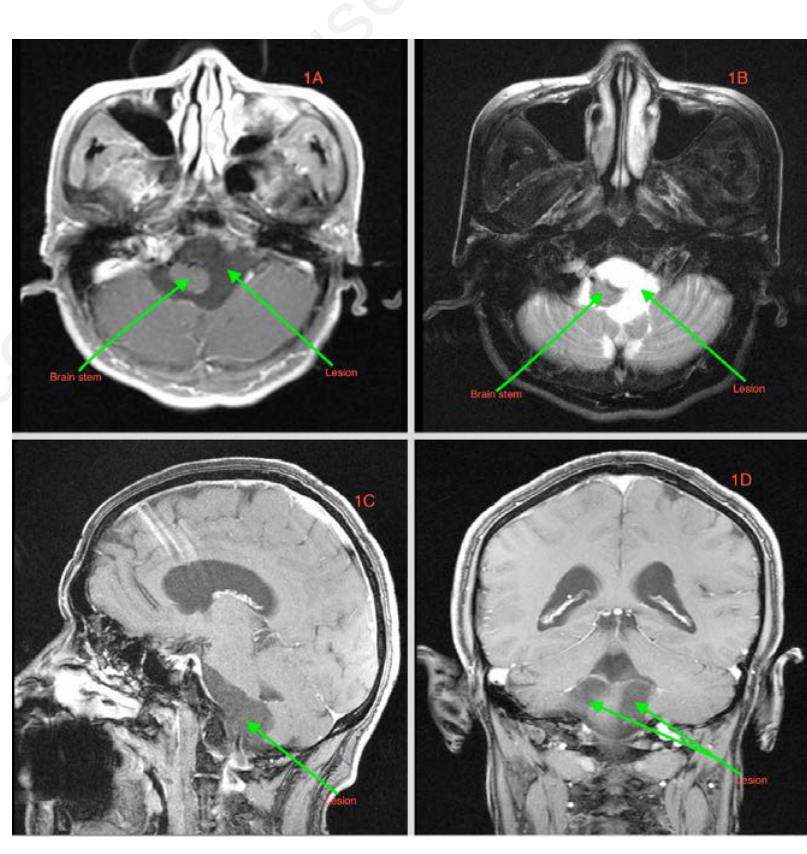
Figure 1. A,B) are axial T1 and T2 respectively. The lesion is hypo-intense on T1, hyper- intense on T2. The lesion compressed the medulla oblongata on the right side and the hemisphere bilaterally with intense pressure on the medulla oblongata and the cerebel- lum. C) is a sagittal view of the lesion on T1. The lesion is lying on the posterior fossa floor and extending to the foramen magnum. D) is coronal View of the lesion on T1; showing the third, fourth and bilateral ventricles which are slightly enlarged with mild obstructive hydrocephalus. The lesion is